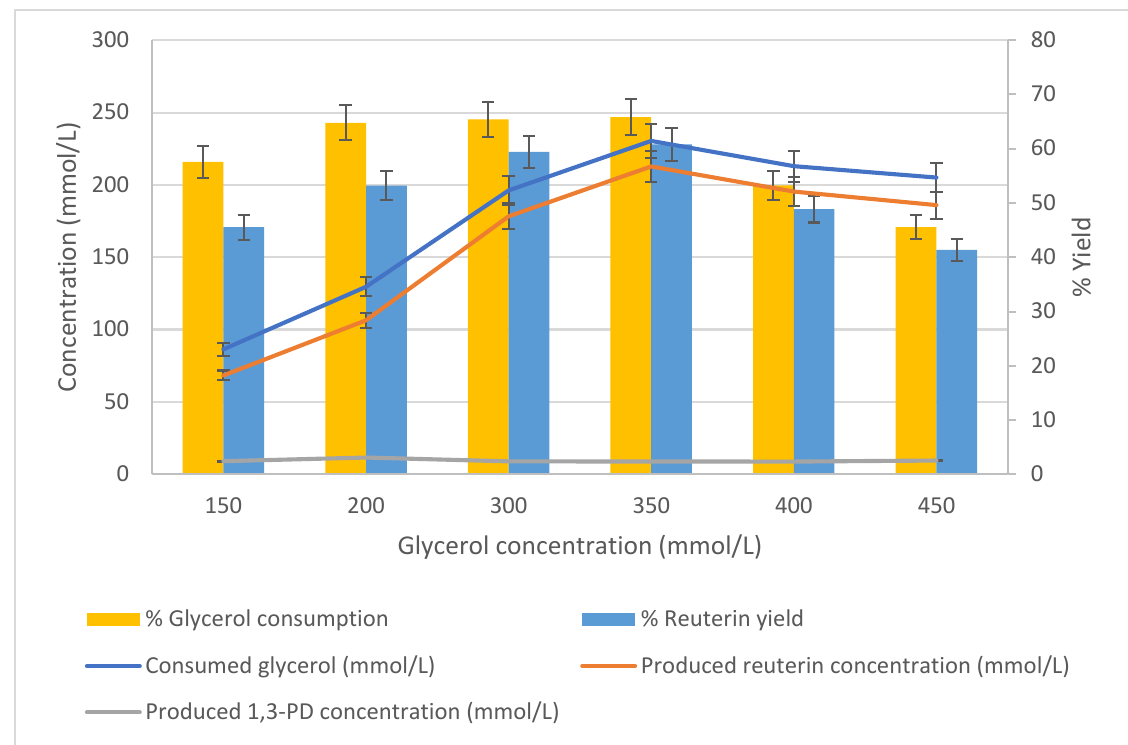
Figure 6. Effect of initial glycerol concentration on reuterin production.